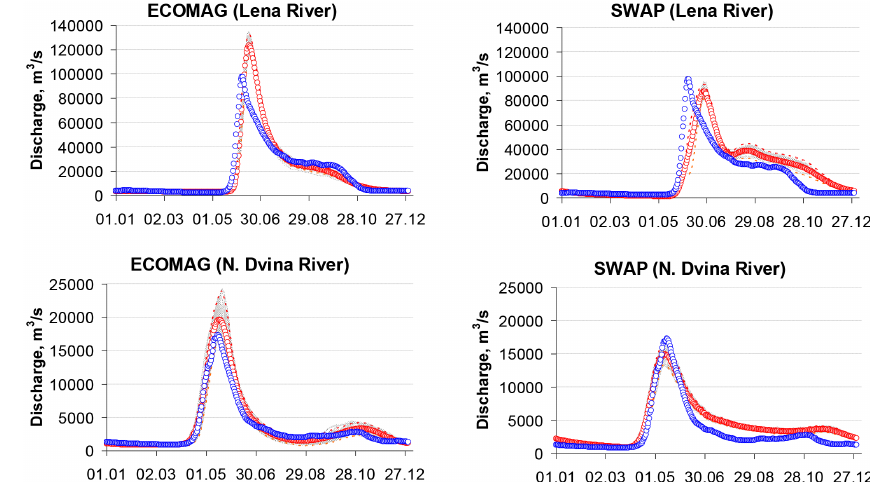
Figure 7. M estimates of the daily discharges at the outlets of the Lena River (top panels) and the Northern Dvina River (bottom panels). Blue points show estimates based on observational data for the period of 1979–2012. Red points show estimates based on ensemble simulations (gray thin lines). Red dotted line shows the boundaries of the 95% confidence interval of mean daily discharges.